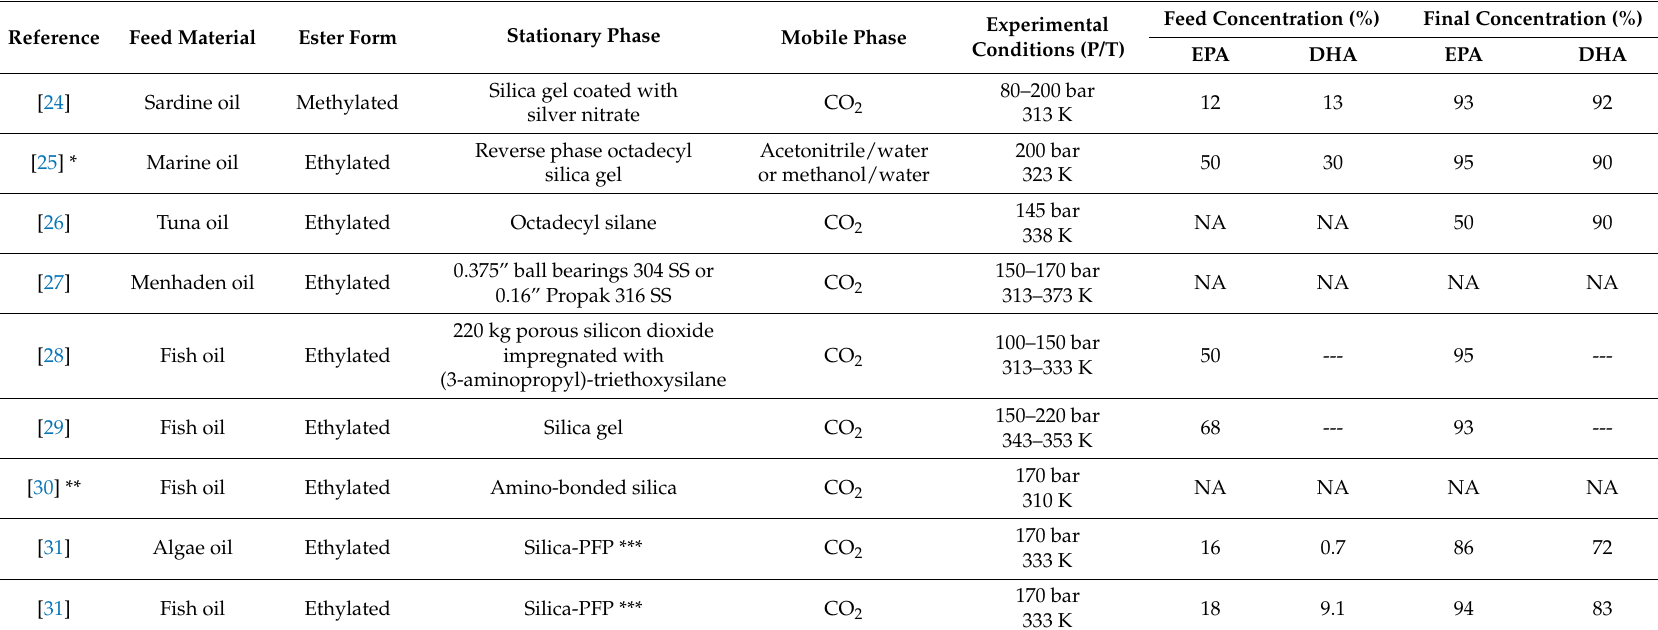
Table 1. ω -3 enrichment summary using SFC